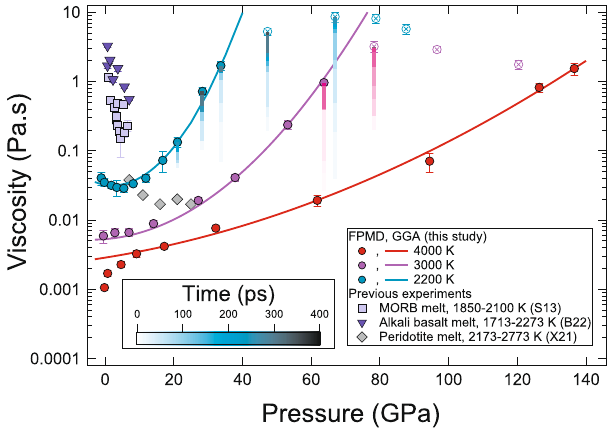
Fig. 3 | Melt viscosity as a function of pressure. The viscosity of model basaltic melt along different isotherms: 4000K ( fi lled red circles), 3000K ( fi lled purple circles),and 2200K ( fi lledcyancircles) asa function of pressure (this study, GGA). The solid curves represent a modi fi ed VFT model (Eq. 2) at 4000K (red), 3000K (purple), and 2200K (cyan). Open circles with crosses are the calculated results thatare not converged. Blue and purple shaded verticallines in selectedpressures show the viscosity calculation using various simulation times (in picoseconds) as indicated in the color bar in the fi gure. Filled purple squares, blue fi lled downward facing triangles, and fi lledyellow diamonds are the experimental viscosity data for multi-component silicate melts: MORB (S13) 31 , alkali basalt (B22) 34 , and peridotite (X21) 10 , respectively. Error in viscosities represents ±1 σ